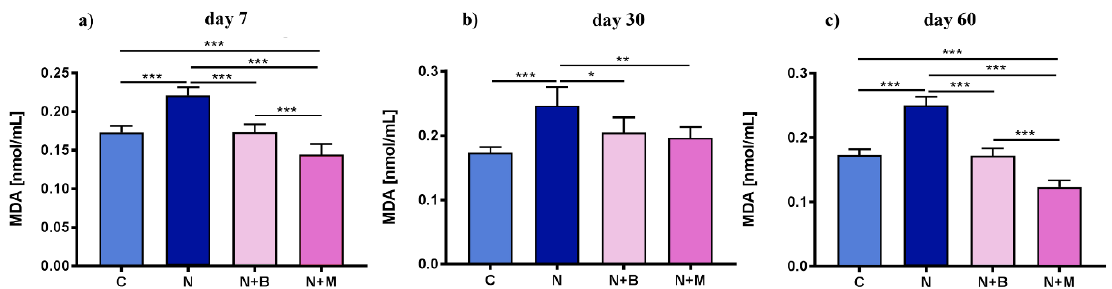
Figure 1. Content of malondialdehyde (MDA) in plasma under acoustic stress conditions after 7, 30, and 60 days. Animals ( n = 6) were exposed for 60 days to noise (N) or left untreated (C). Mesedin (M) and beditin (B) were injected daily i.p. to the rats exposed to chronic noise (N + M and N + B, respectively). One-way ANOVA with Sidak’s multiple comparison test, * p < 0.05, ** p < 0.01, *** p < 0.001. The mean ± SEM values of plasma content of MDA on days 7, 30, and 60 after exposure of noise and mesedin/beditin are shown in ( a ), ( b ), and ( c ), respectively.